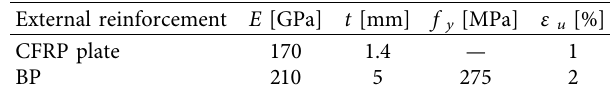
Table 2: Parameters for the EBs.